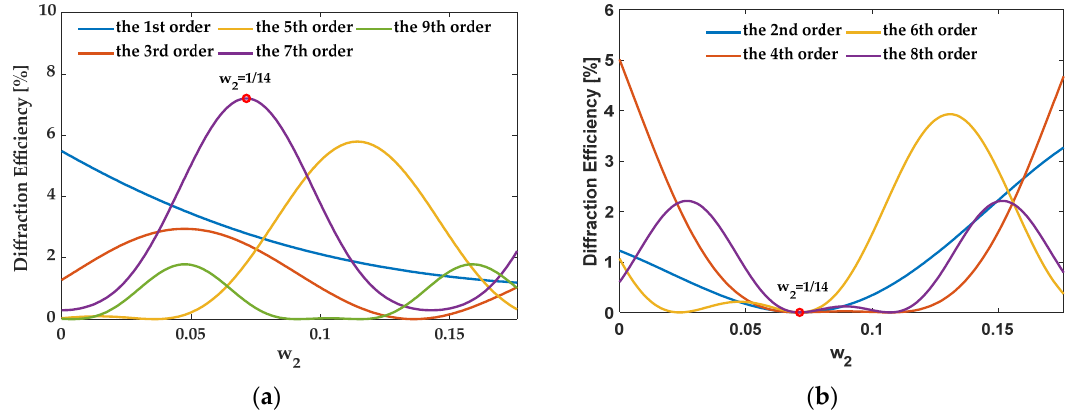
Figure 19. The diffraction efficiency as a function of w 2 when { f i } is {1/14, 1/14, 3/14, 1/14, 1/14}. ( a ) The odd orders, ( b ) the even orders.